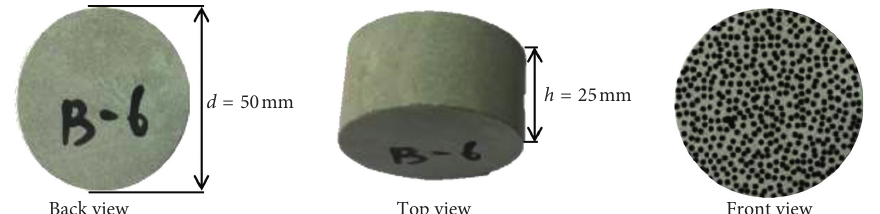
Figure 1: Specimens with nonvisible cracks and weak planes for Brazilian disks. Table 1: Mechanical parameters of the rock samples. Rock samples ρ refers to the density, E refers to the modulus of elasticity, f c refers to the uniaxial compressive strength, ] refers to the Poisson ratio, and φ refers to the internal friction Table 2: Microcomponents of the samples by X-ray diffraction analysis. Mineral components and contents (%) Clay Quartz